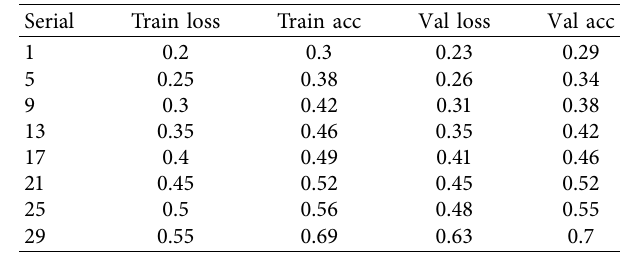
Figure 8: (a) AlexNet loss and accuracy, (b) VGG-16 loss and accuracy, (c) ResNet-50 loss and accuracy, and (d) training results of diferent network models. Table 4: AlexNet loss and accuracy. Table 5: VGG-16 loss and